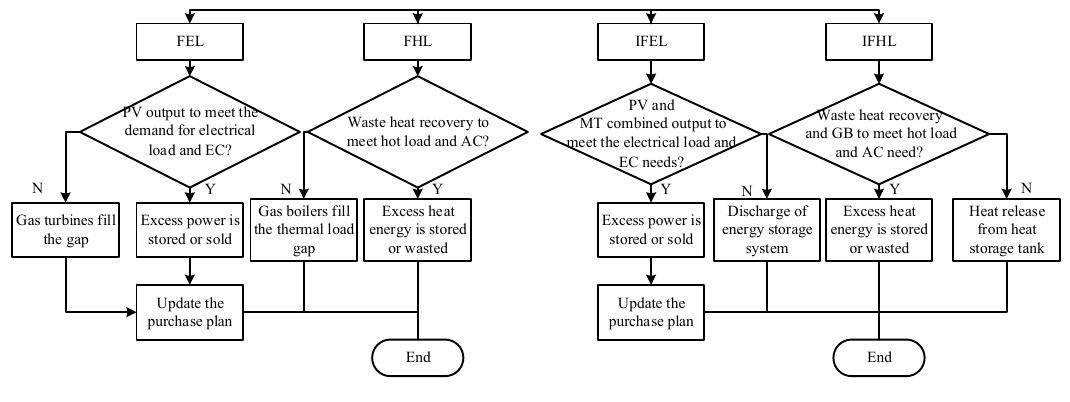
Figure 3. Flowchart of four strategies.